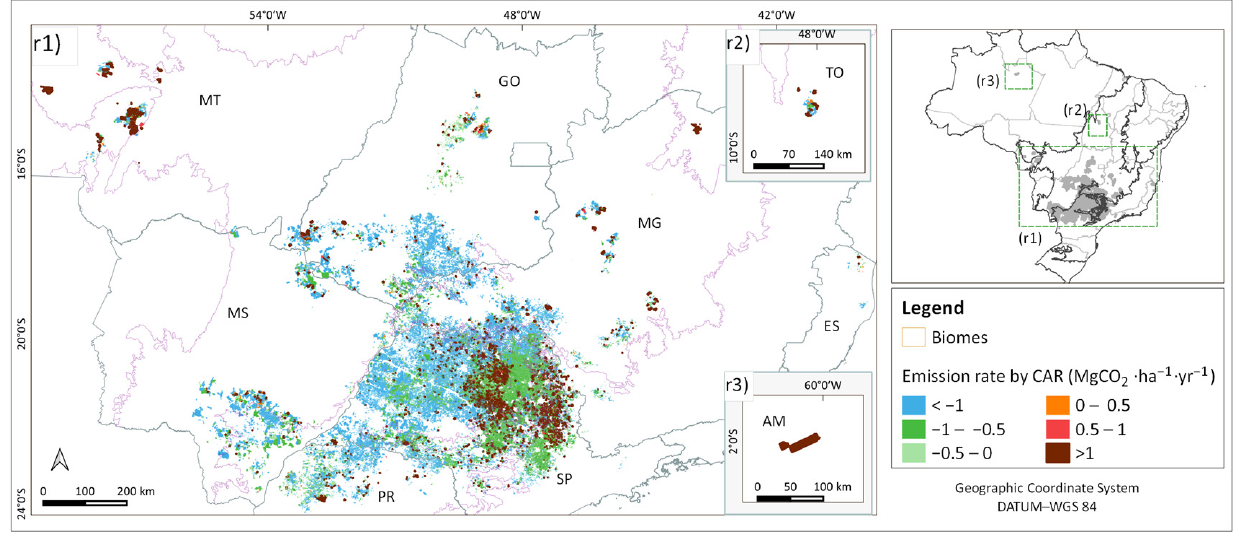
Figure 10. Annual net emissions/removals rate per area (MgCO 2 ∙ ha − 1 ∙ yr − 1 ) in parametrization D for each CAR in 2000–2020 due to the LUC that occurred within sugarcane-producing CARs.